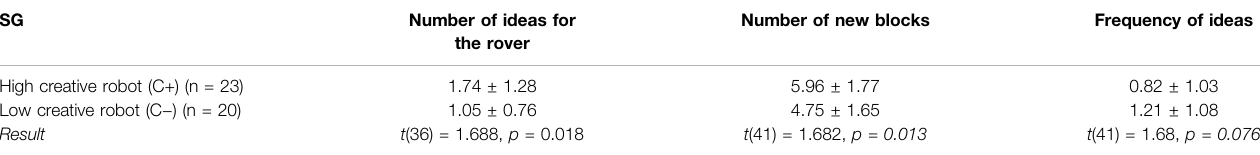
TABLE 5 | WeDo construction task results comparing the fl uency and originality of idea, and divergent thinking expressed by participants in the three study groups. SG